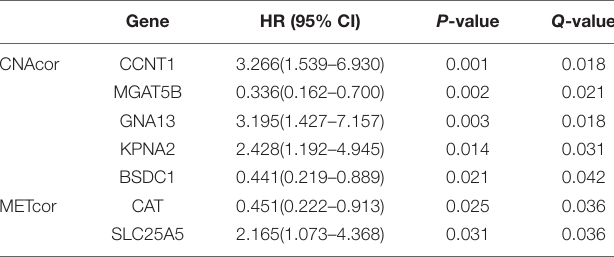
TABLE 2 | Computationally validated associations of CNAcor or METcor with OS of BRCA patients. Gene P -value Q